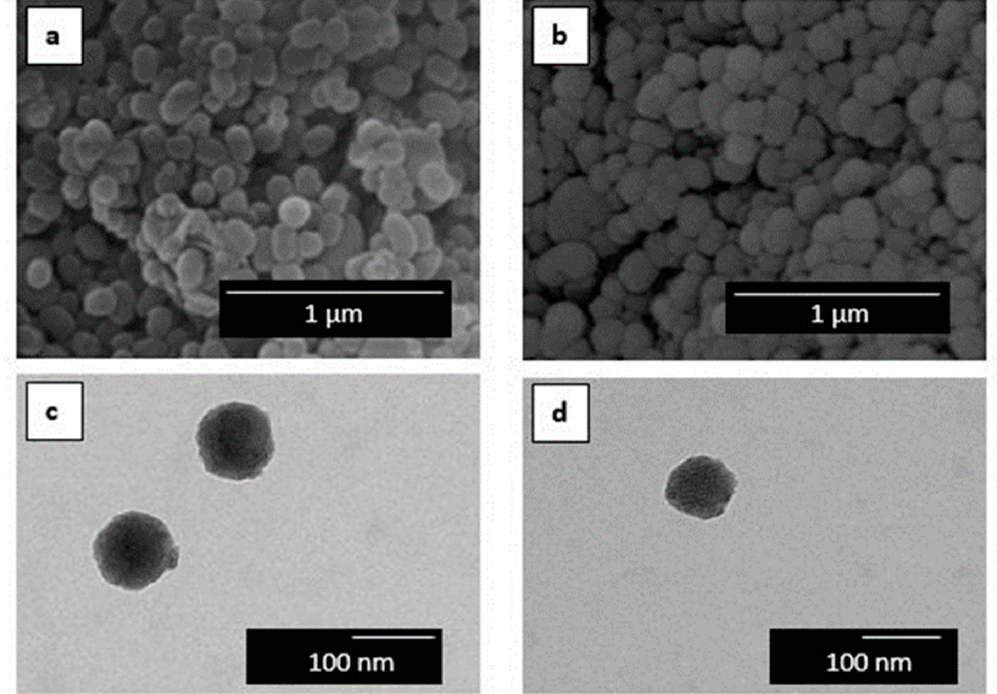
Figure 1. Scanning electron microscopy (SEM) images of: ( a ) Mobil Composition of Matter (MCM-41); ( b ) MCM-41 with eugenol. Scale markers of 1 µm. Transmission electron microscopy (TEM) images of: ( c ) MCM-41 and ( d ) MCM-41 with eugenol. Scale markers of 100 nm.